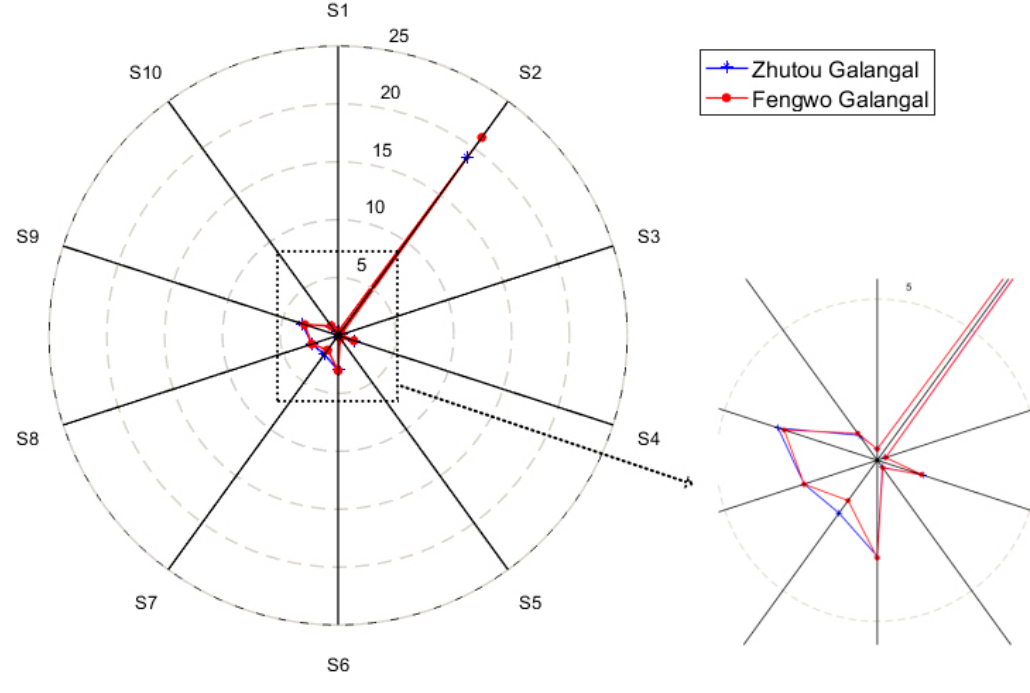
Figure 2. Radar plots of Zhutou galangal and Fengwo galangal.